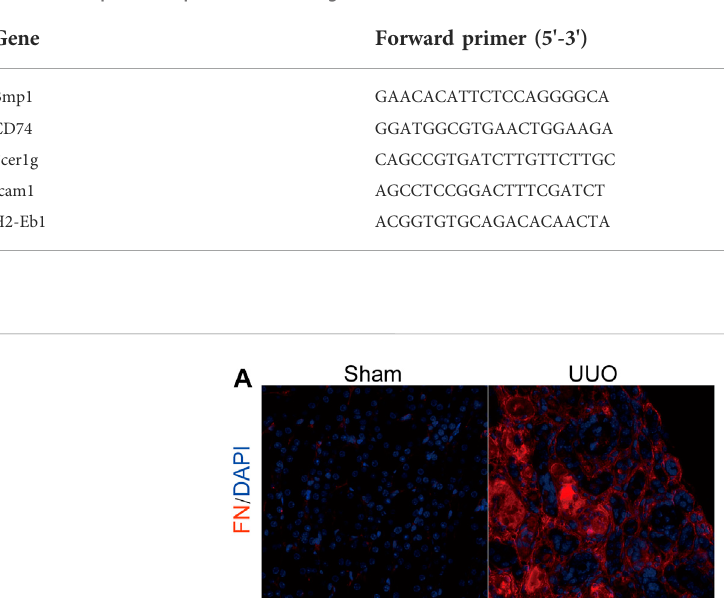
TABLE 1 The primer sequences of 5 hub genes.